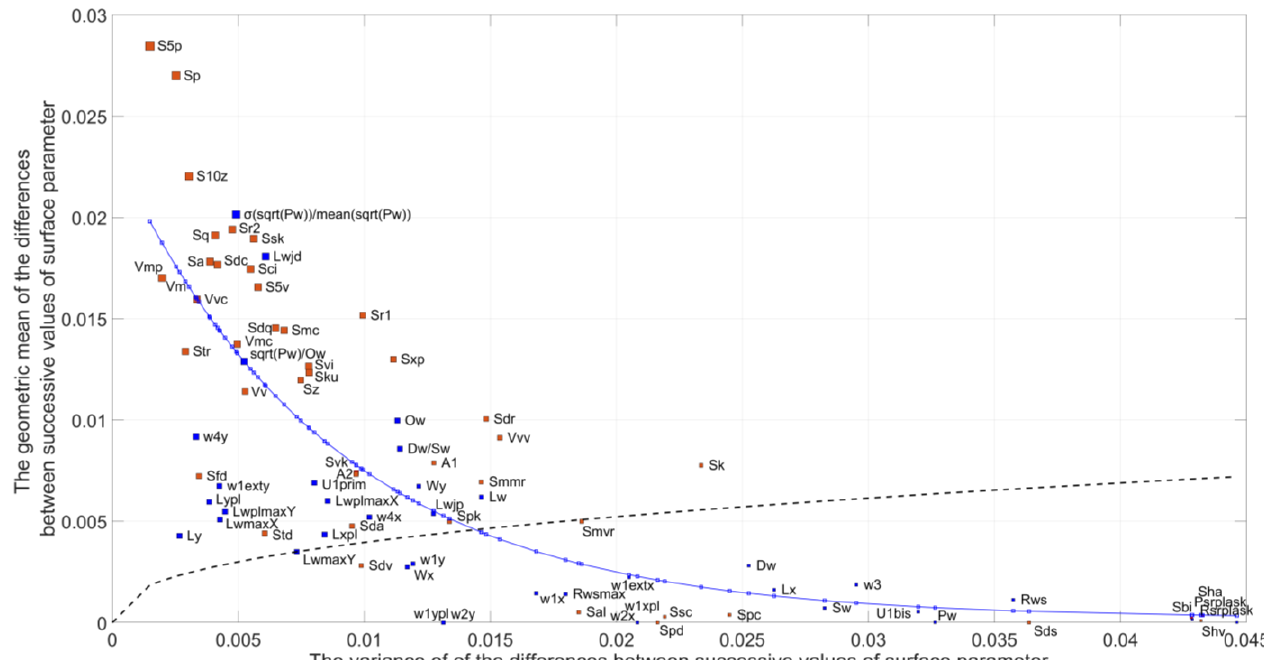
Figure 9. Dependence of the geometric mean of the differences of successive values of the analyzed parameters (determined for each plot from the adopted set) on the variance of these differences .